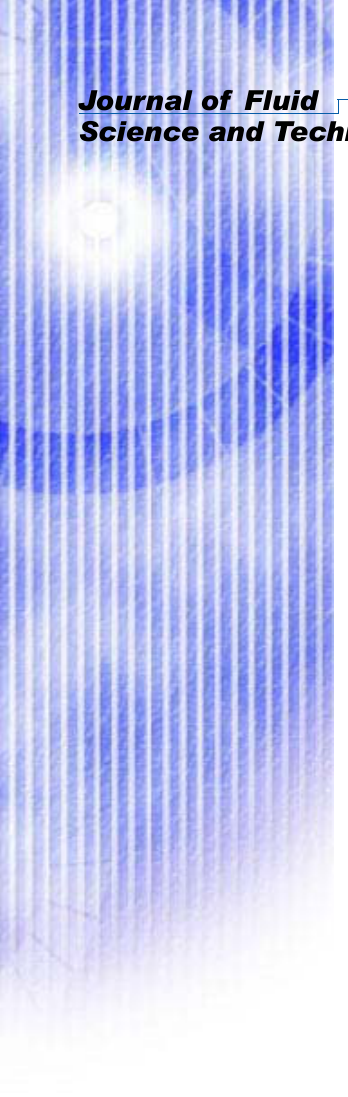
Fig.2 Flow control